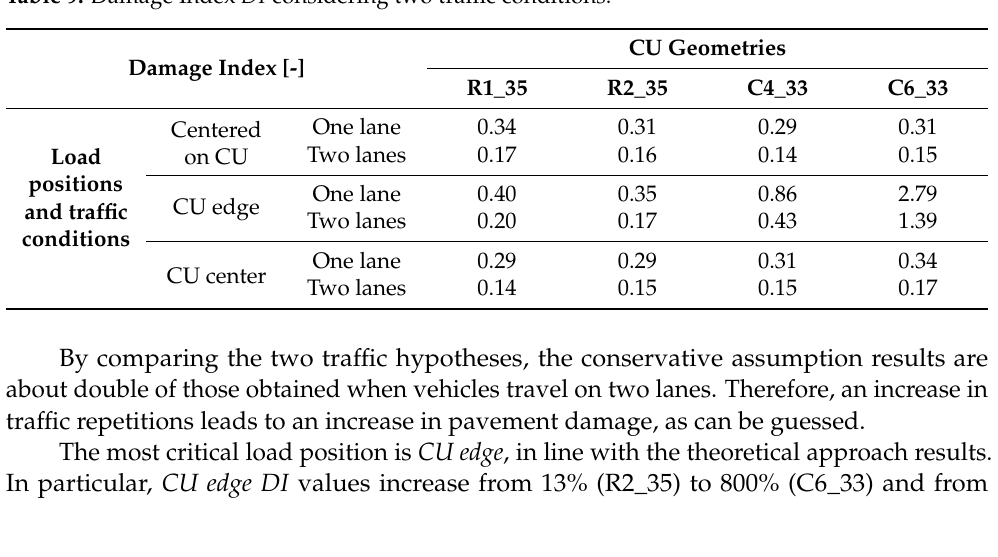
Table 9. Damage Index DI considering two traffic conditions.